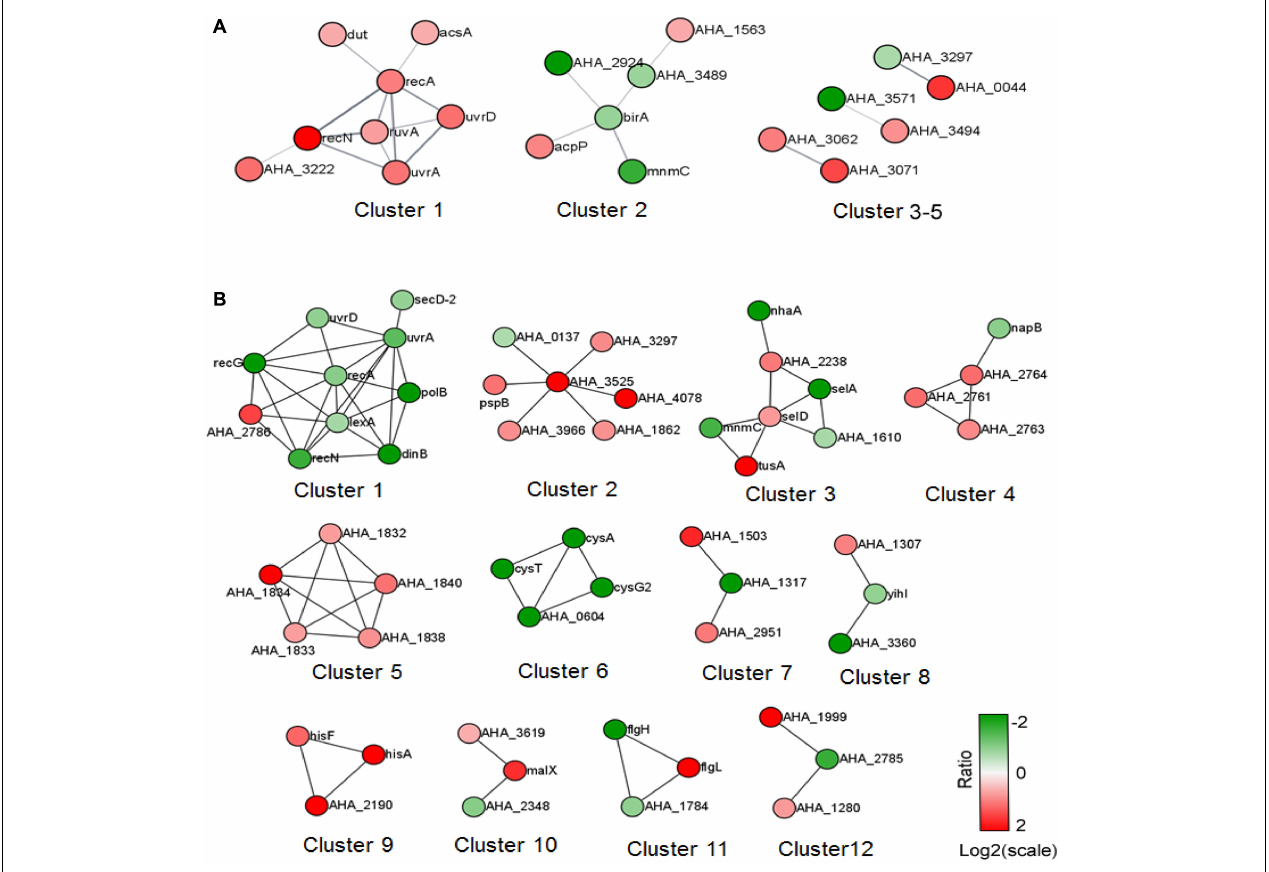
FIGURE 4 | The PPI prediction network of altered proteins in the two comparisons. (A) (cid:49) ahslyA + ENX vs. WT + ENX, and (B) (cid:49) ahslyA + ENX vs. (cid:49) ahslyA . The green dots represent downregulated proteins and red dots represent upregulated